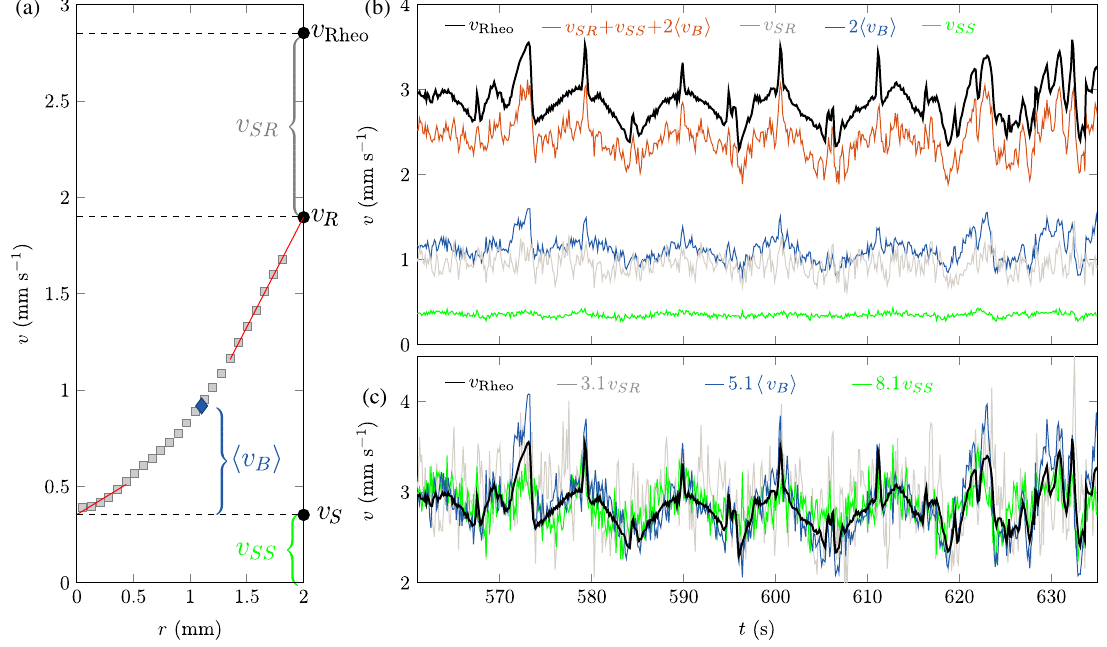
FIG. 14. Velocities in regime I for σ ¼ 12 Pa. (a) Average velocity profile h v ð r; z; t Þi stator. The red lines show the linear fits used to extrapolate the velocity of the sample at the walls. (b) Time series of the various velocities defined in Appendix 6 and highlighted in (a). (c) The same velocities rescaled so as to match the time average of v